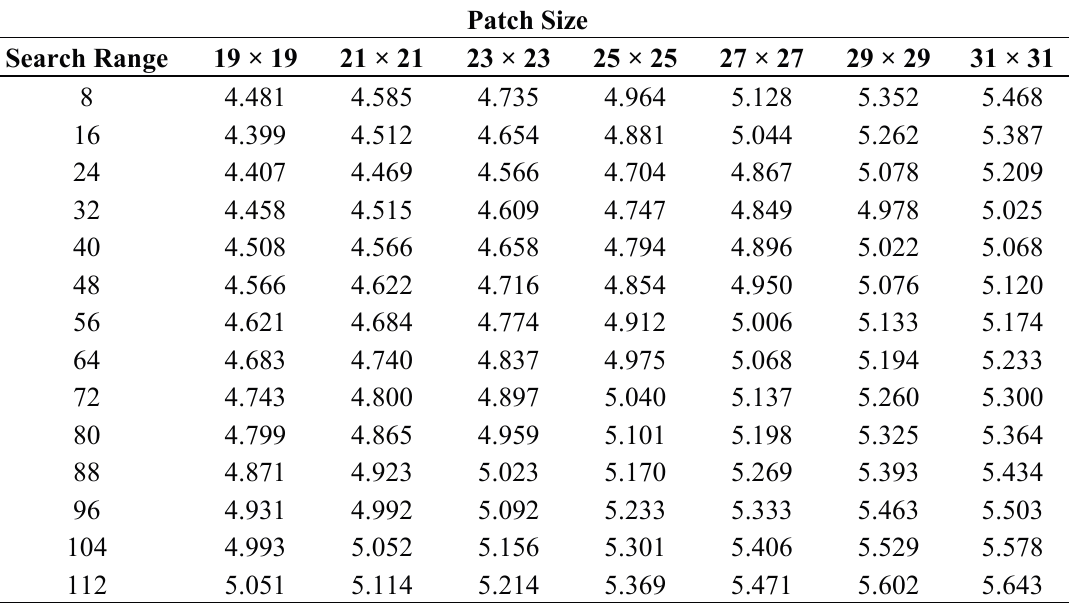
Table 4. Mean computational time vs. bigger patch size. Patch